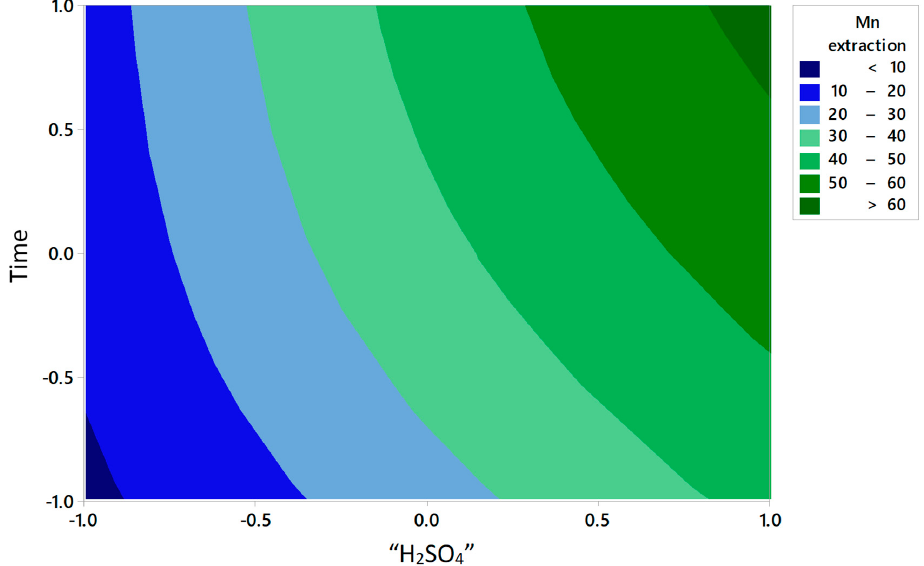
Figure 2. Experimental contour plot of Mn extraction (25 ◦ C, − 100 + 140, − 200 + 270, − 320 + 400 sieve fraction mesh, 5, 10, 20, 30, 40 min leaching time, H 2 SO 4 0.1, 0.5, 0.75, 1 M and 1 MnO 2 /Fe M ratio) .